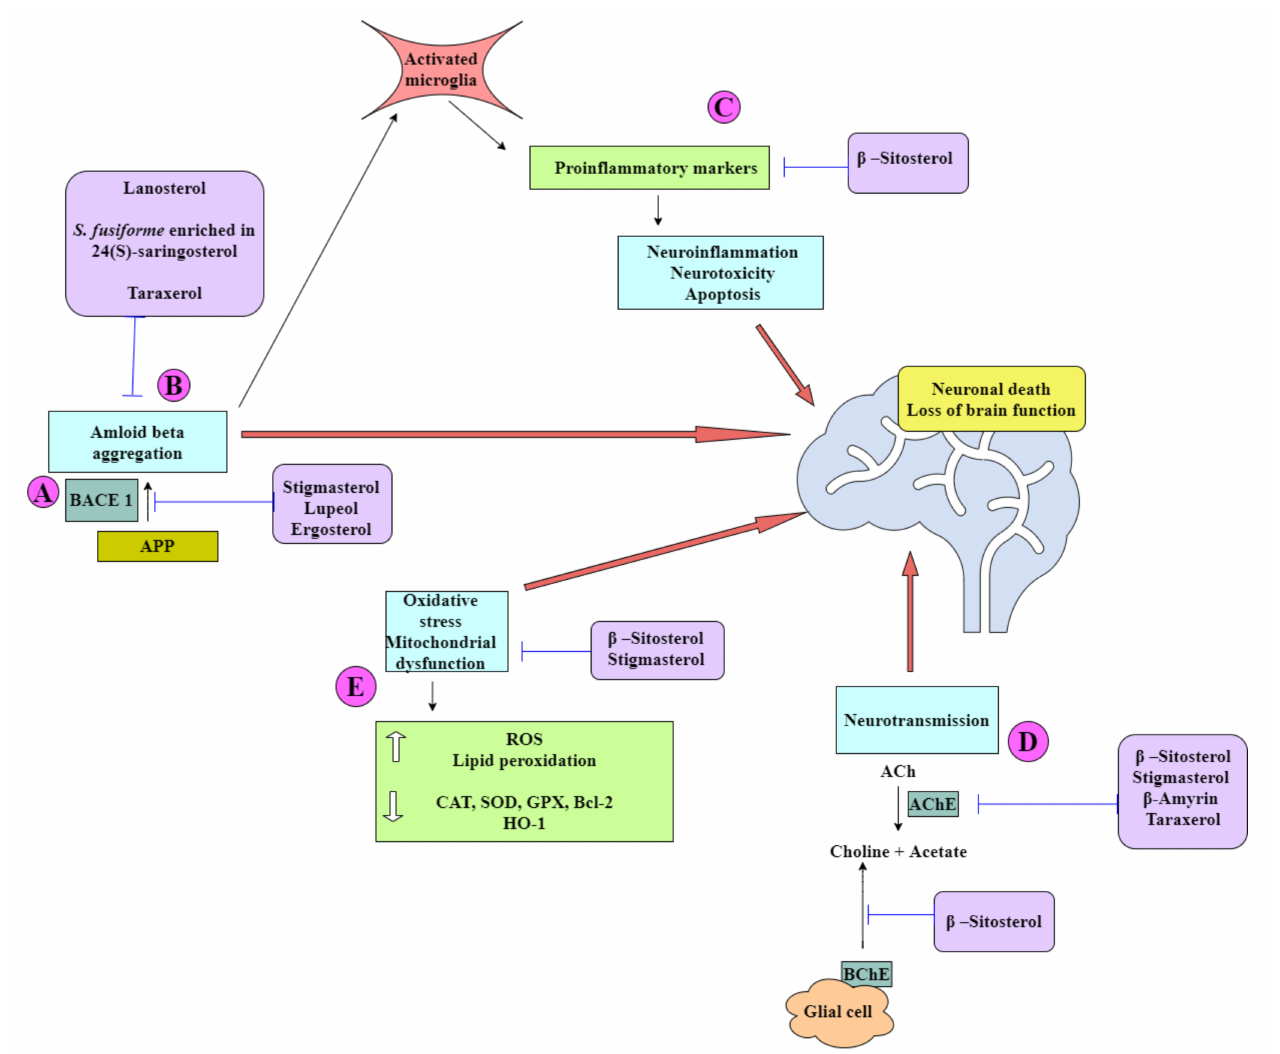
Figure 5. Phytosterols exert a multitarget approach to ameliorate symptoms of AD. ( A ) Some prevent amyloid- beta aggregation by inhibiting cleavage of the amyloid precursor protein (APP) by β -secretase (BACE-I). This causes a shift in the non-amyloidogenic pathway and reduces the levels of A β produced. ( B ) A β can self-aggregate to form oligomers and eventually amyloid plaques. Some phytosterols are able to inhibit the formation of amyloid plaques by binding to A β , inhibiting aggregation, and thereby promoting the formation of nontoxic oligomers. Toxic A β monomers and oligomers have been shown to induce microglial activation and proliferation. Activated microglia secrete pro-inflammatory cytokines such as IL-1 β and IL-6. ( C ) Some phytosterols have been shown to reduce the levels of these cytokines. Some phytosterols reduce oxidative stress by increasing the levels of antioxidant enzymes and reducing lipid peroxidation. ( D ) Acetylcholine (ACh), a neurotransmitter essential for processing memory and learning, is decreased in both concentration and function in AD. Decreased levels of ACh can be restored by anticholinesterase activity of various phytosterols. ( E ) ROS irreversibly oxidize DNA and are important mediators of A β -induced neuronal cell death in the development of AD. Abbreviations: APP: Amyloid Precursor Protein; AChE: Acetyl Cholinesterase Enzyme; BACE 1: Beta-Secretase 1; BChE: Butyl Cholinesterase Enzyme; Bcl-2: B-Cell Lymphoma 2; CAT: Catalase; GPX: Glutathione Peroxidase; HO 1: Heme Oxygenase; ROS: Reactive Oxygen Species; SOD: Superoxide